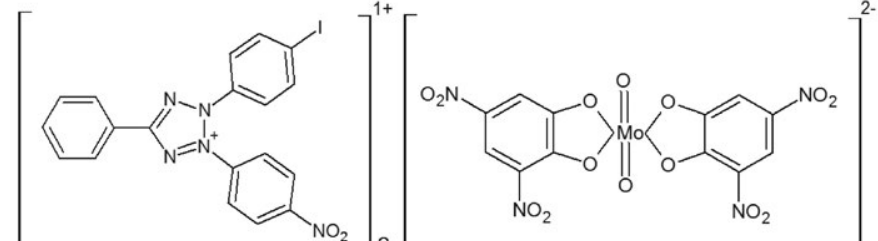
Figure 7. Structure of the ion-associated complex